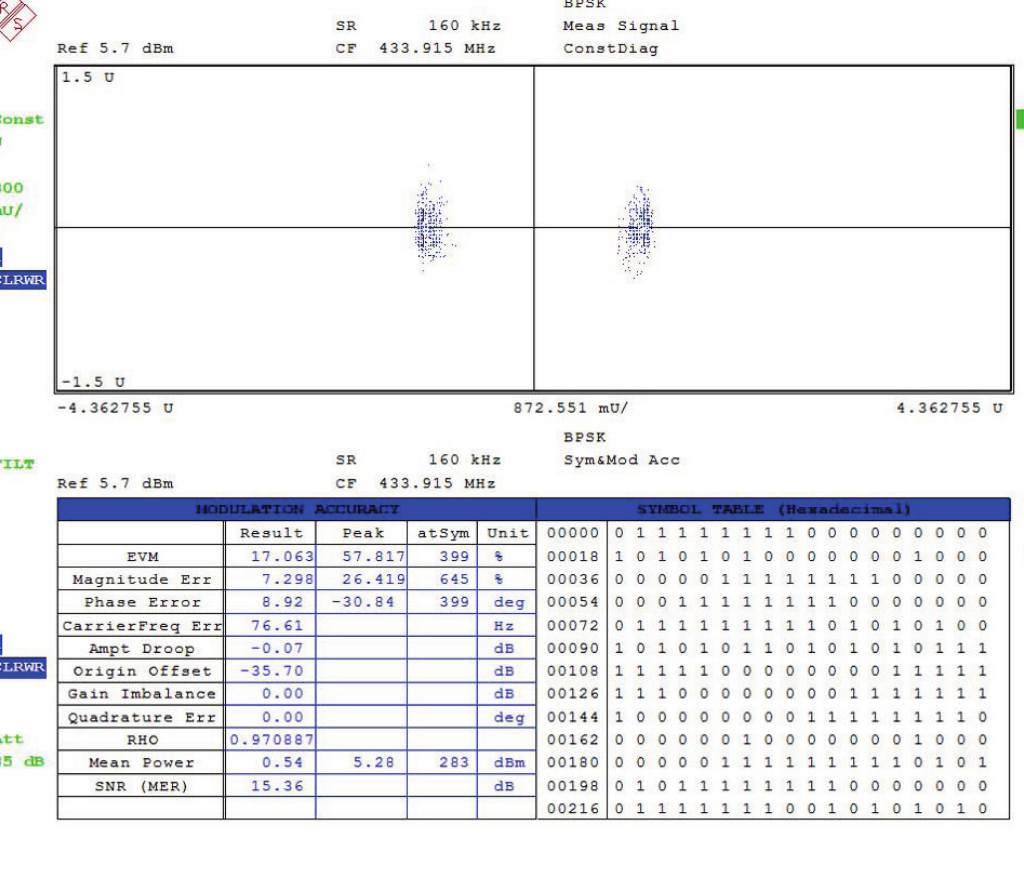
Figure 14. Measured error vector magnitude